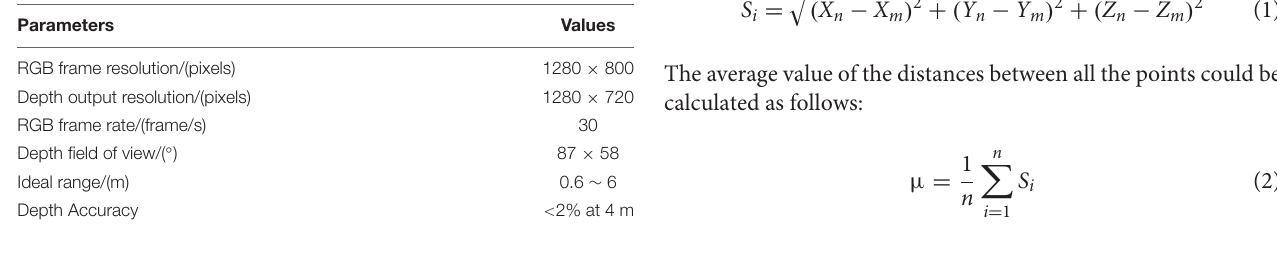
TABLE 1 | Parameters of the D455 depth